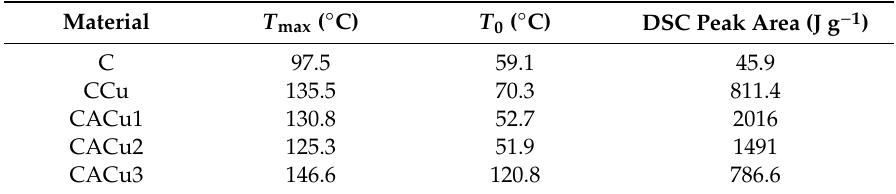
Table 3. TGA parameters for the di ff erential scanning calorimetry (DSC) thermogram profiles for chitosan and its composite materials.